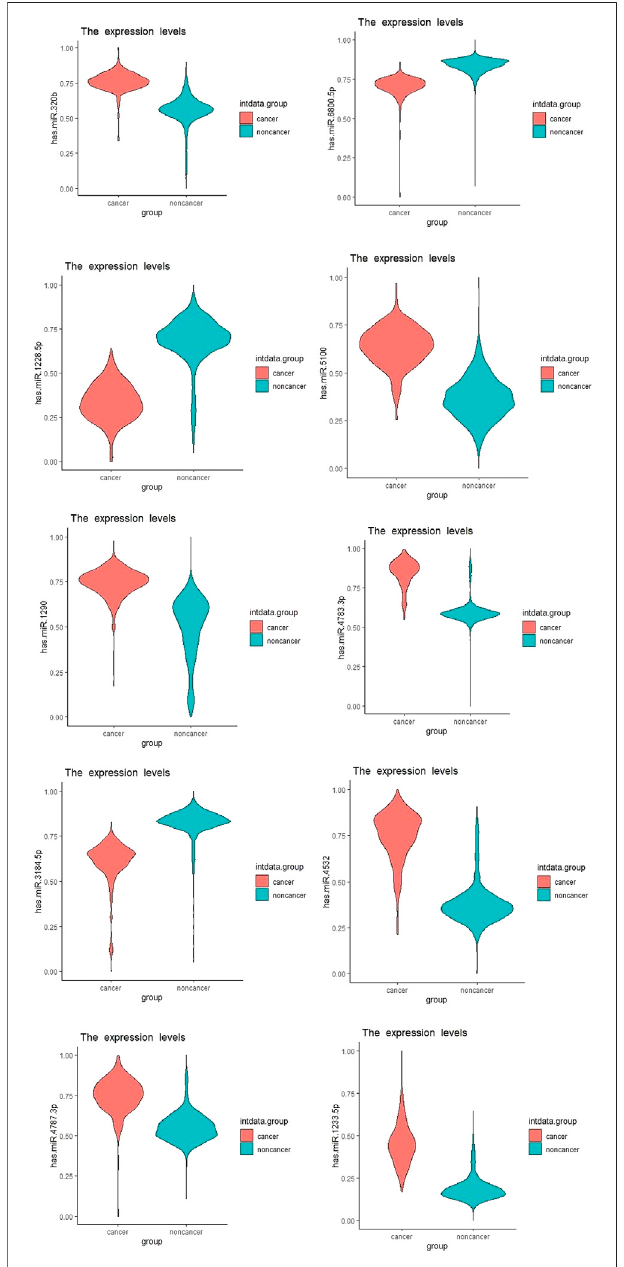
FIGURE2| Boxplotsofthe10identi fi edmiRNAsinovariancancerpatients compared with the non-cancer control patients in the dataset GSE106817.